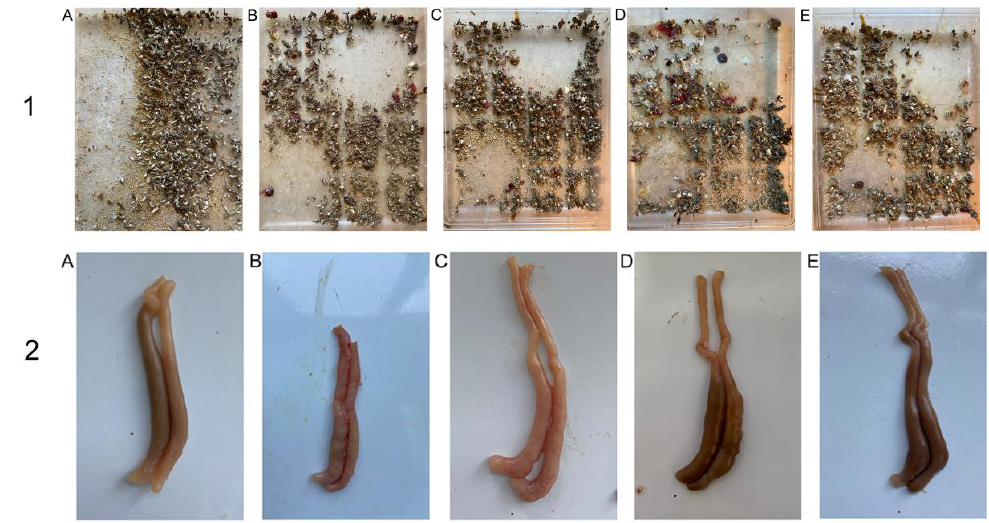
Figure 14. The images of hematochezia (1) and cecum (2) of chicken. ( A ) NC, ( B ) PC, ( C ) DNC, ( D ) NIC commercial product, ( E ) DNC/GA/PVP K30 SD. ( D ) NIC commercial product, ( E ) DNC/GA/PVP K30